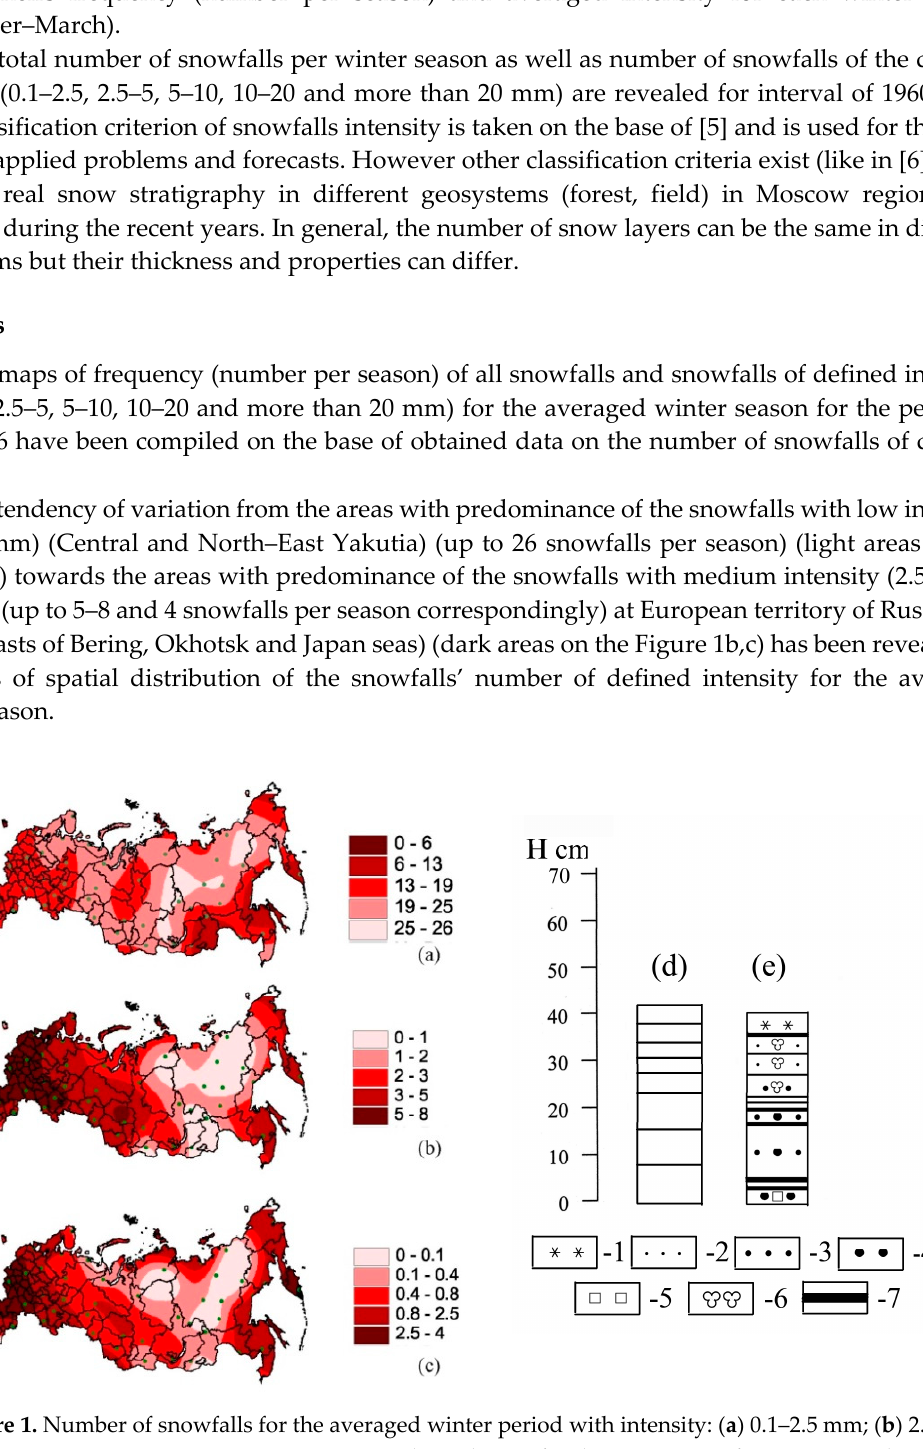
Figure 1. Number of snowfalls for the averaged winter period with intensity: ( a ) 0.1–2.5 mm; ( b ) 2.5– 5 mm; ( c ) 5–10 mm. Moscow region stratigraphic columns for the maximum of snow accumulation: ( d ) modeled, generalized-averaged for winter seasons 1960–2016; ( e ) real observations for winter season 2014/15. Snow stratigraphy notation: ( 1 ) new snow; ( 2 ) fine-grained snow; ( 3 ) medium-grained snow; ( 4 ) coarse-grained snow; ( 5 ) faceted crystals; ( 6 ) refrozen ice crystals; ( 7 ) ice